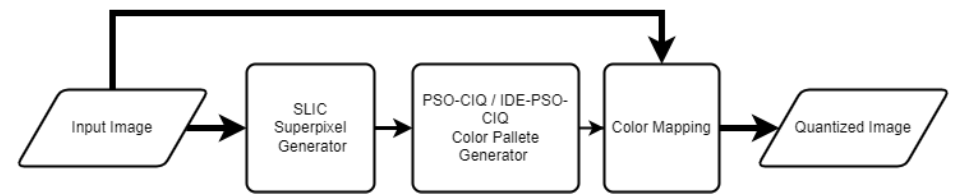
Figure 1. General idea of SP versions of the PSO-CIQ and IDE-PSO-CIQ